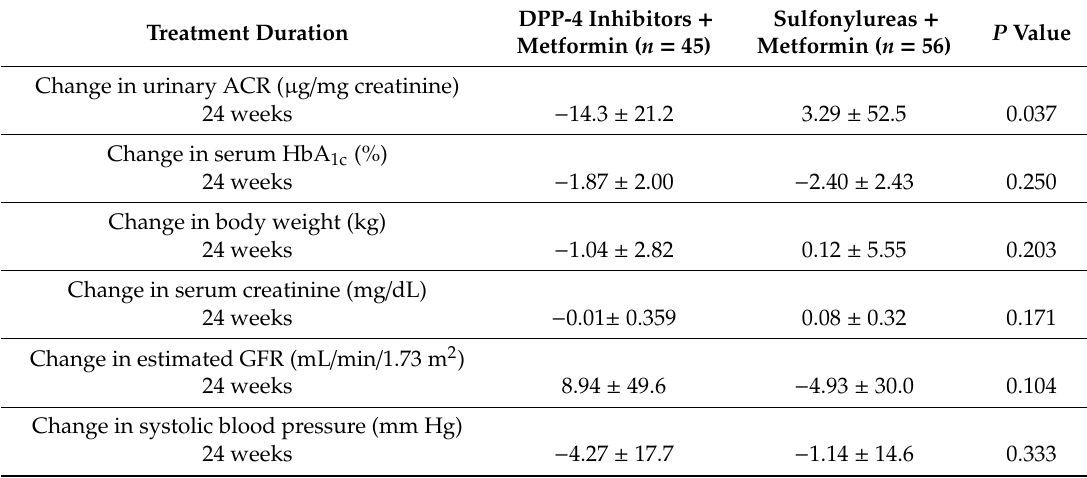
Table 3. Comparison of outcome measures between dipeptidyl-peptidase 4 inhibitors and sulfonylureas. Treatment